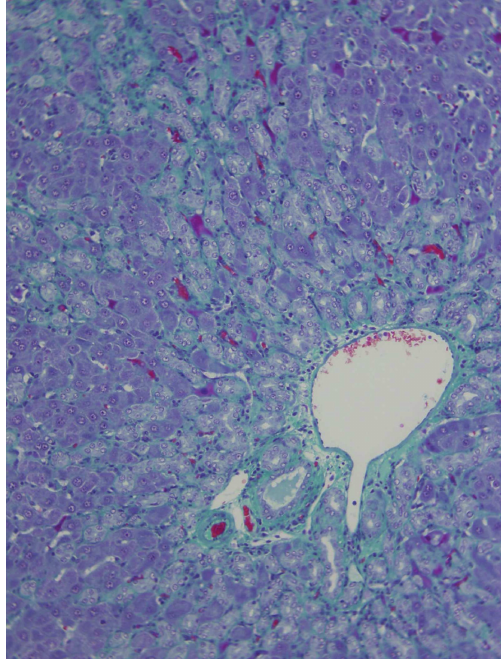
Figure 5: Liver fibrosis and biliary ductular proliferation after 6 weeks of microsurgical extrahepatic cholestasis in the rat (Masson,